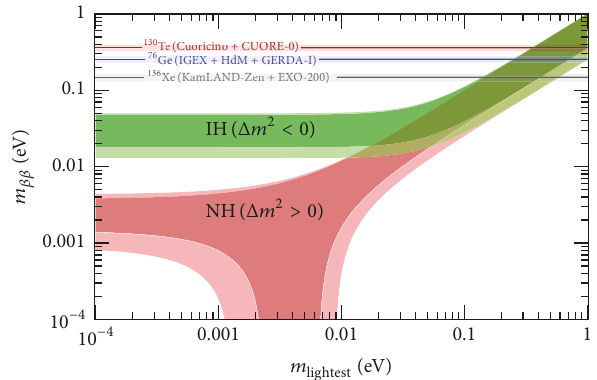
Figure 2: Updated prediction on 𝑚 훽훽 from neutrino oscillations as a function of the lightest neutrino mass according to the current neutrino data. In the figure, both normal and inverted hierarchy schemes for neutrino masses are displayed. Figure taken from [45]. In the figure is also visible the current limit from KamLAND-Zen.